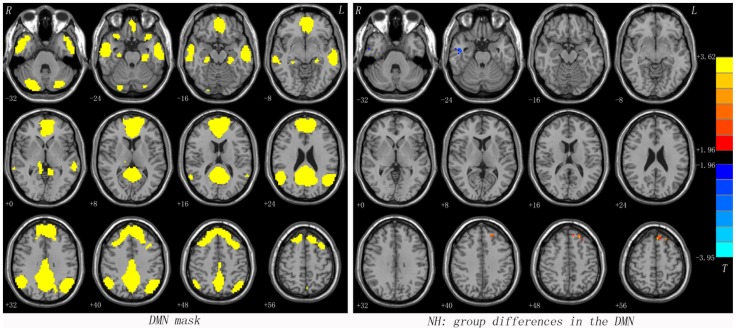
The DMN mask determined by ICA from the control group and statistical maps showing NH differences between subject groups.Red and blue denote higher and lower NH, respectively. Colored bars indicate the T value from two-sample t-tests. DMN = default mode network; ICA = independent component analysis; NH = network homogeneity.